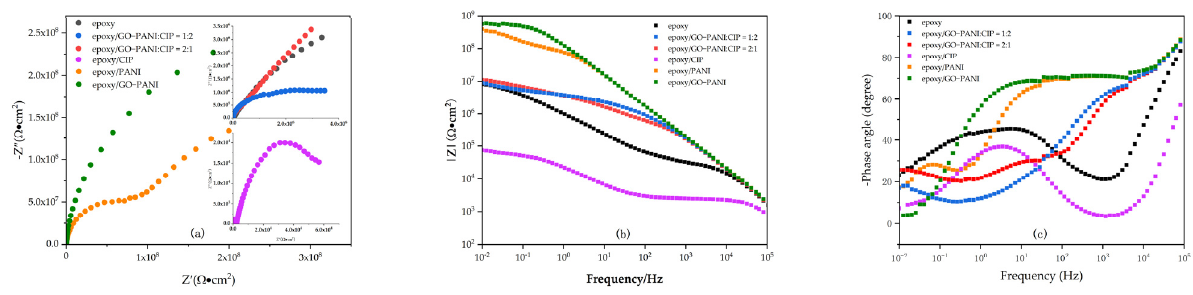
Figure 9. Nyquist plots ( a ) and Bode plots ( b , c ) for epoxy, CIP, PANI, GO − PANI and CIP/GO − PANI composites with different ratios.